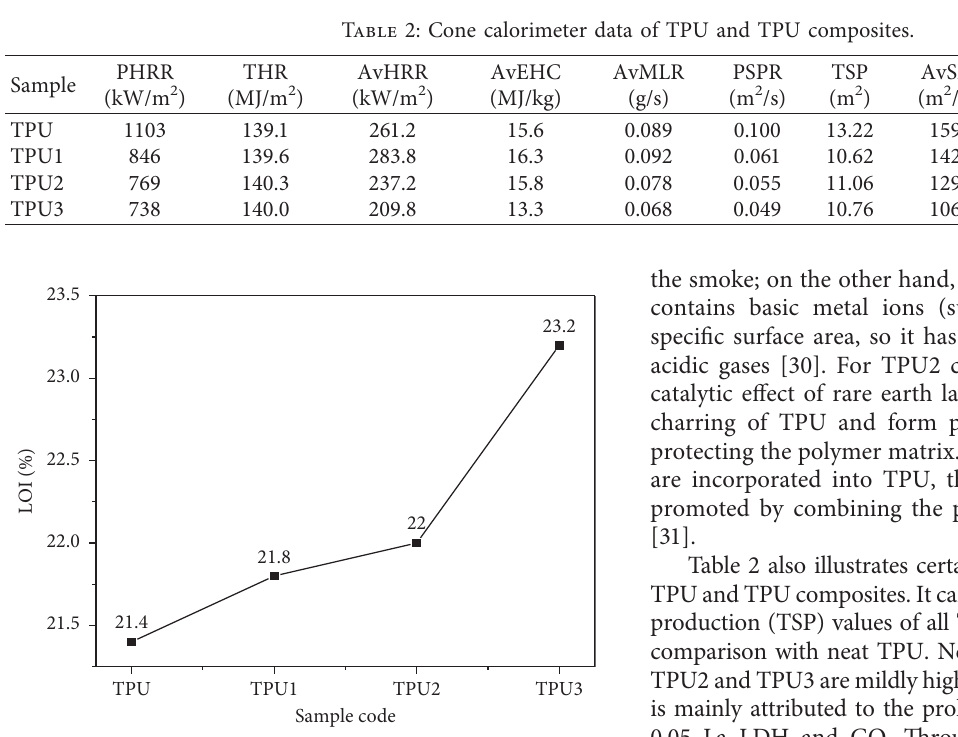
Figure 6: LOI results of TPU and TPU composites.